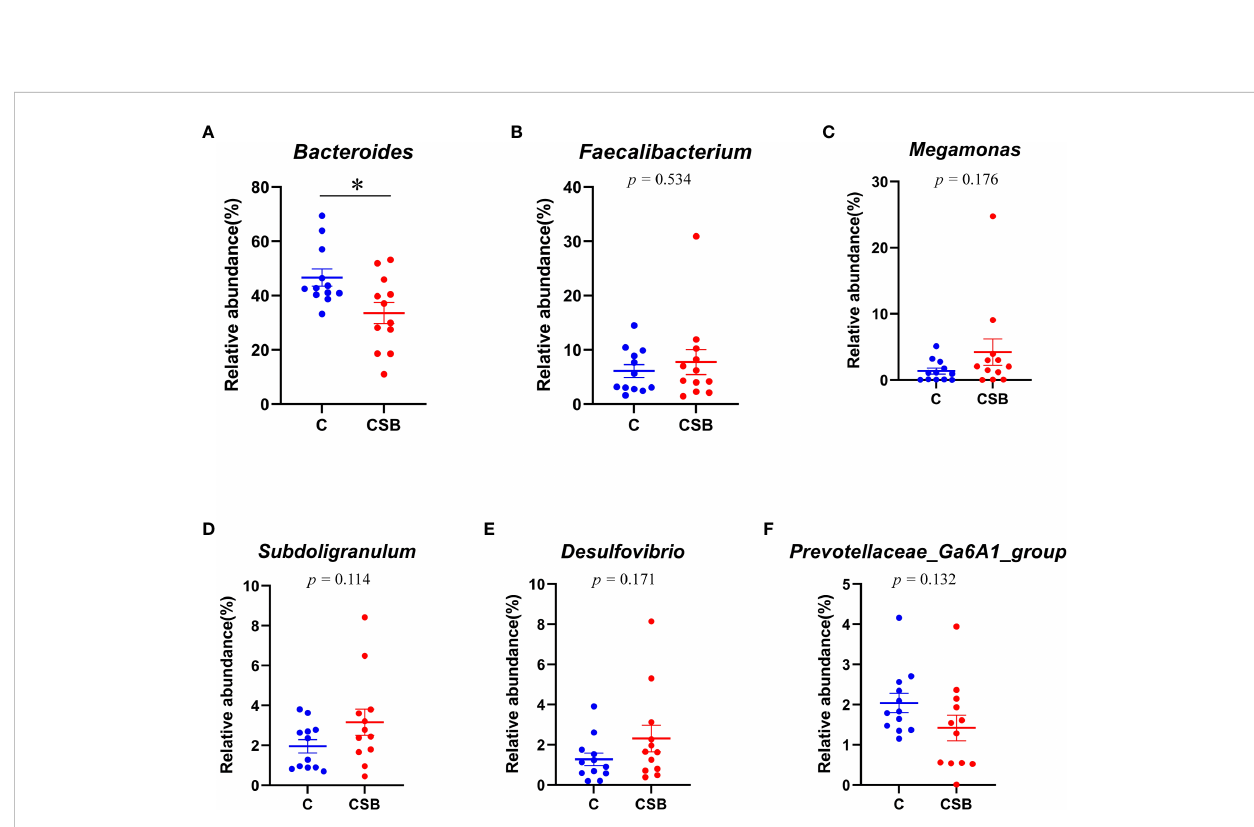
FIGURE 9 Effects of dietary supplementation of coated sodium butyrate (CSB) on the relative abundance of the cecal microbiota of laying ducks at the phylum level. (A) Bacteroidetes. (B) Firmicutes. (C) Proteobacteria. (D) Deferribacteres. (E) Actinobacteria. (F) Fusobacteria. Values are presented as means ± SEM (n = 12). * p< 0.05. group C, Control group, which was fed a basal diet; CSB group, CSB-treated group, which was fed the basal diet supplemented with 250 g/t of